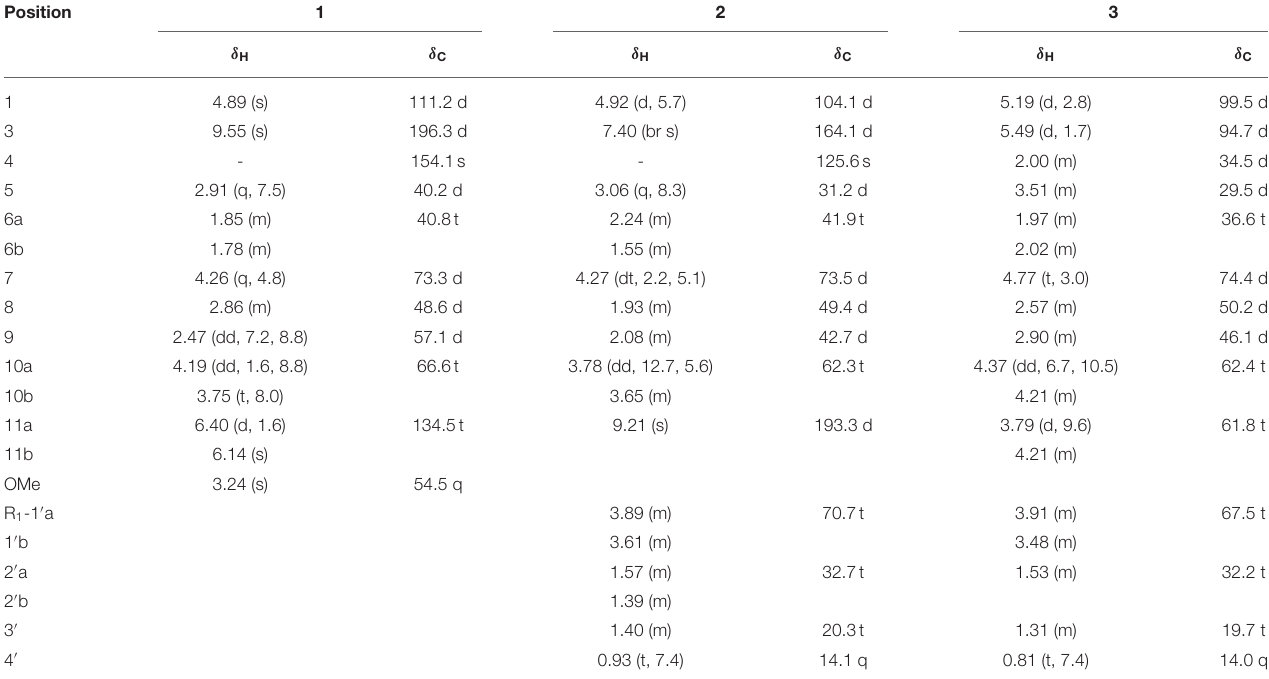
TABLE 1 | The 1 H and 13 C NMR data of 1-4 (CD 3 OD, δ in ppm, J in Hz).